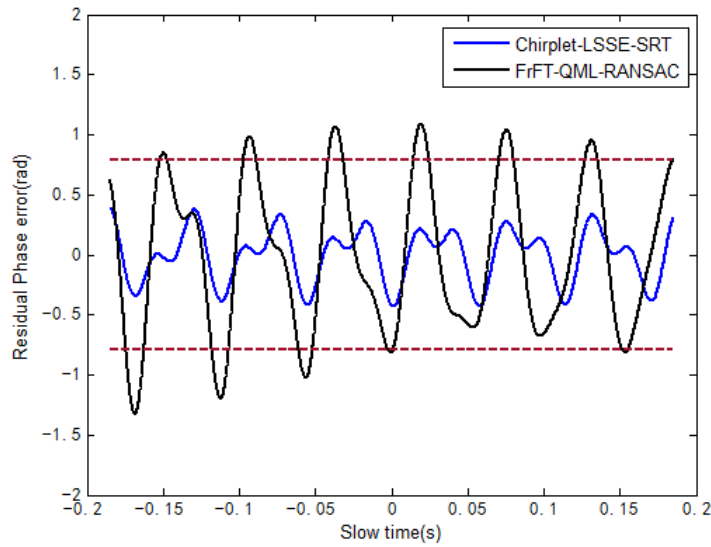
Figure 8. Residual phase errors.